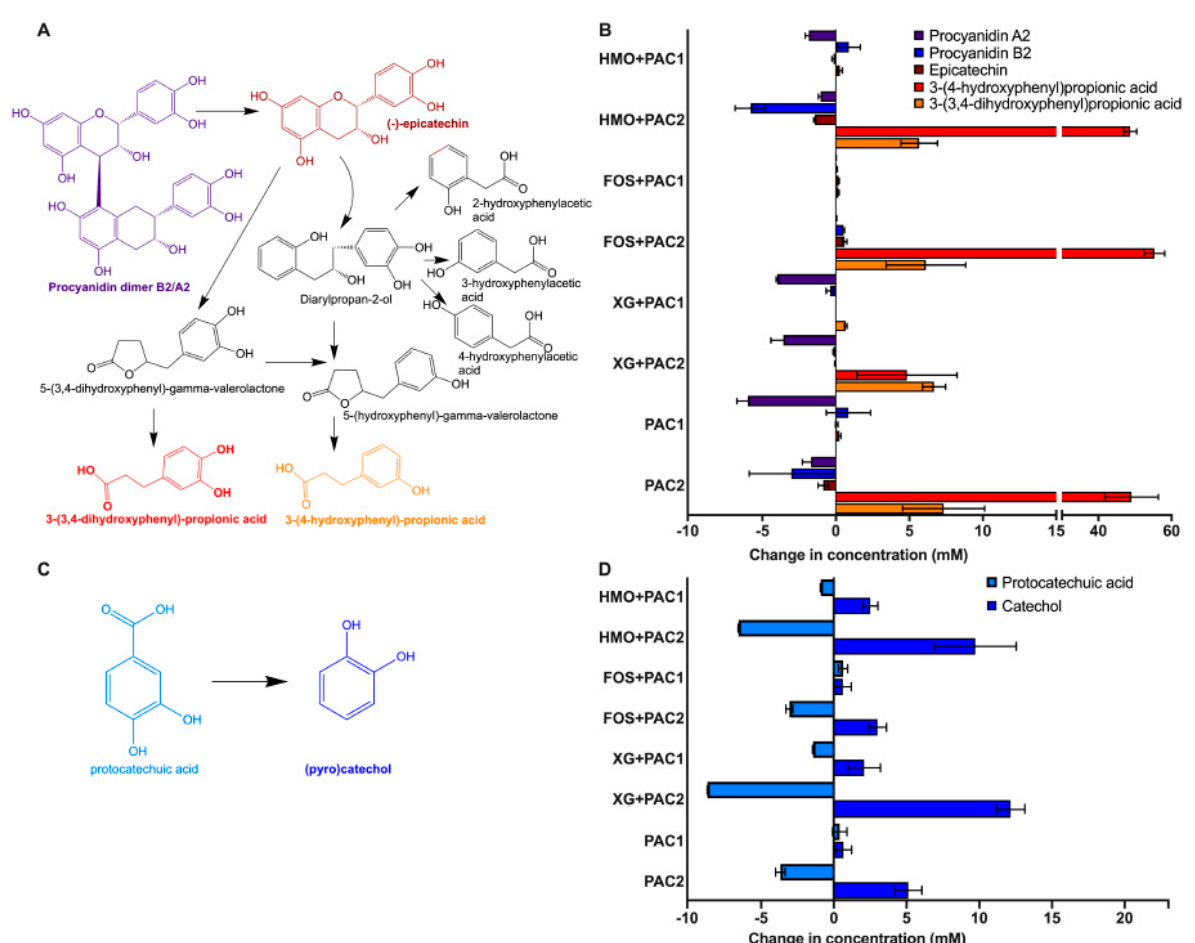
Figure 4. Lactobacillus plantarum degradation of phenolic compounds. Schematic diagram of potential degradation pathways of procyanidin A2 and B2 dimers ( A ) and the change in phenolic metabolite concentration following fermentation ( B ). Protocatechuic acid degradation into catechol ( C ) and the quantified change of their concentrations following fermentation ( D ). Averages from independent biological triplicates are shown, and bars represent standard deviation of the mean. Table 1. Cranberry phenolic metabolites produced during Lactobacillus plantarum oligosaccharide fermentation a. PACs in the Absence of Fermentable Carbohydrates